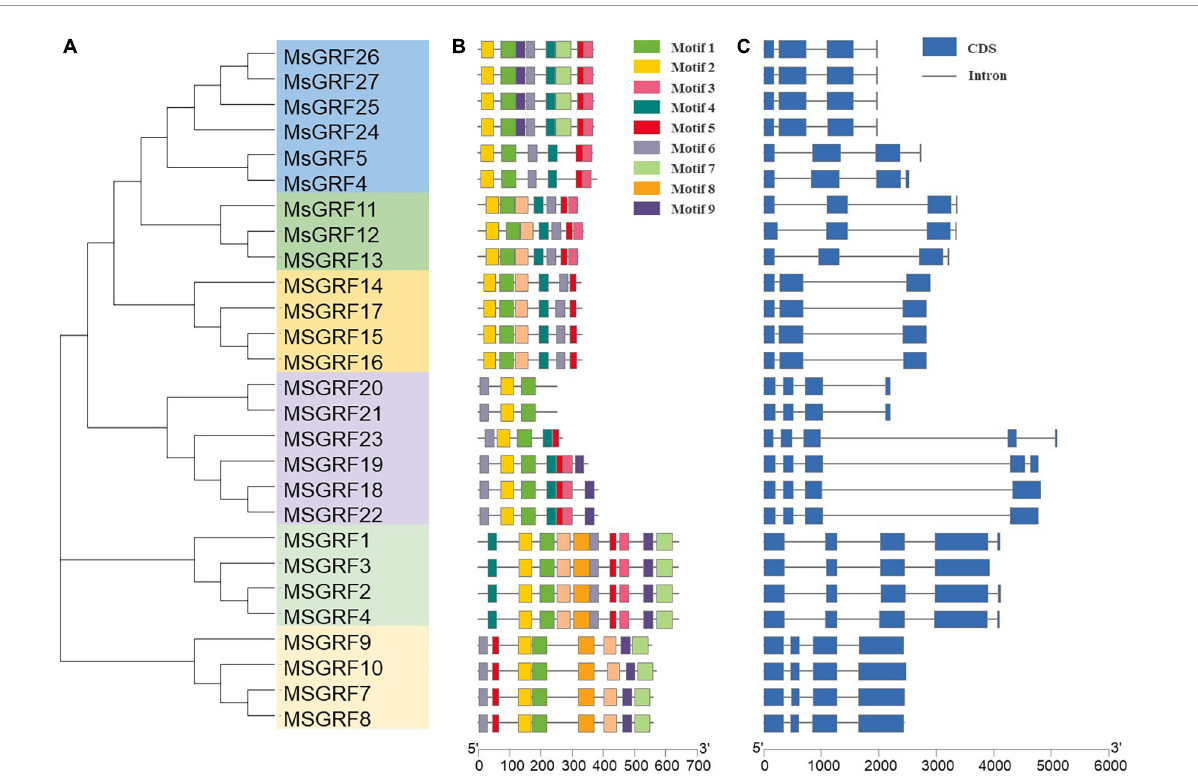
FIGURE2 Analysis on phylogenetic relationships, motifs, and gene structure of growth-regulating factor genes from Medicago sativa . (A) Phylogenetic tree of 27 MsGRFs in alfalfa. (B) Conserved motif arrangements of MsGRFs . The motifs are indicated in different colored boxes with different numbers. Motifs 1 and 2 represent WRC and QLQ domains, respectively. (C) Exon-intron organizations of MsGRFs . Blue boxes indicate exons; black lines indicate